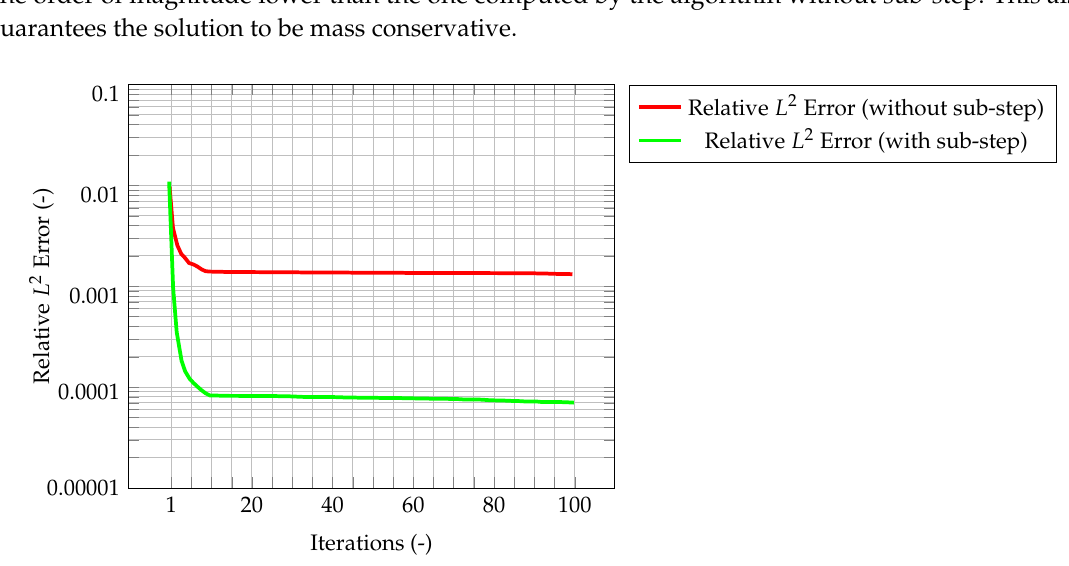
Figure 13. Time evolution of the normalized L 2 error for the mass flux. This error represents the difference between the reference mass flux computed on the fine grid, and the ones computed on the coarser ones with the correction by the filter, respectively, without (red) and with (green) the sub-stepping correction in the